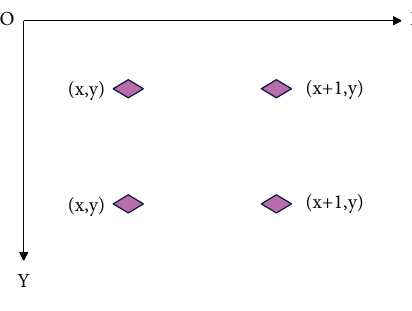
Figure 8: Pixel gray